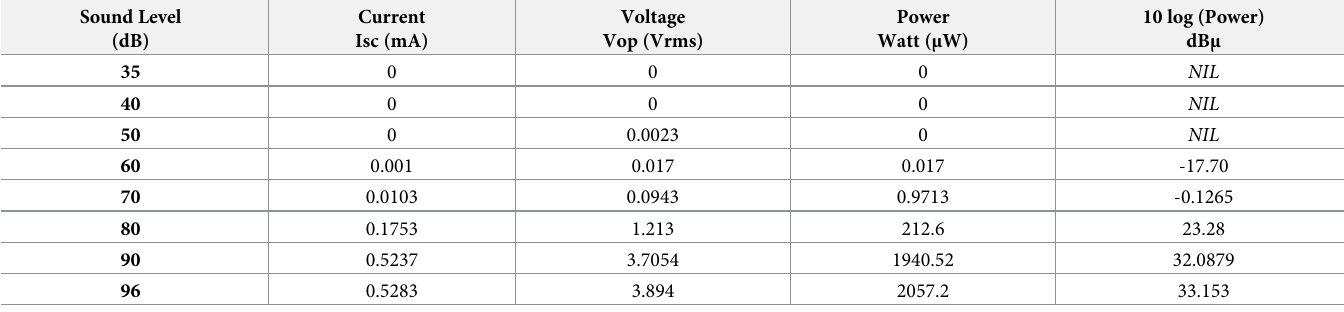
Table 4. The detailed values of current, voltage and power for piezoelectric transducer QB220-503YB that is found in the data sheet of the material [22] modified by researcher. Sound Level